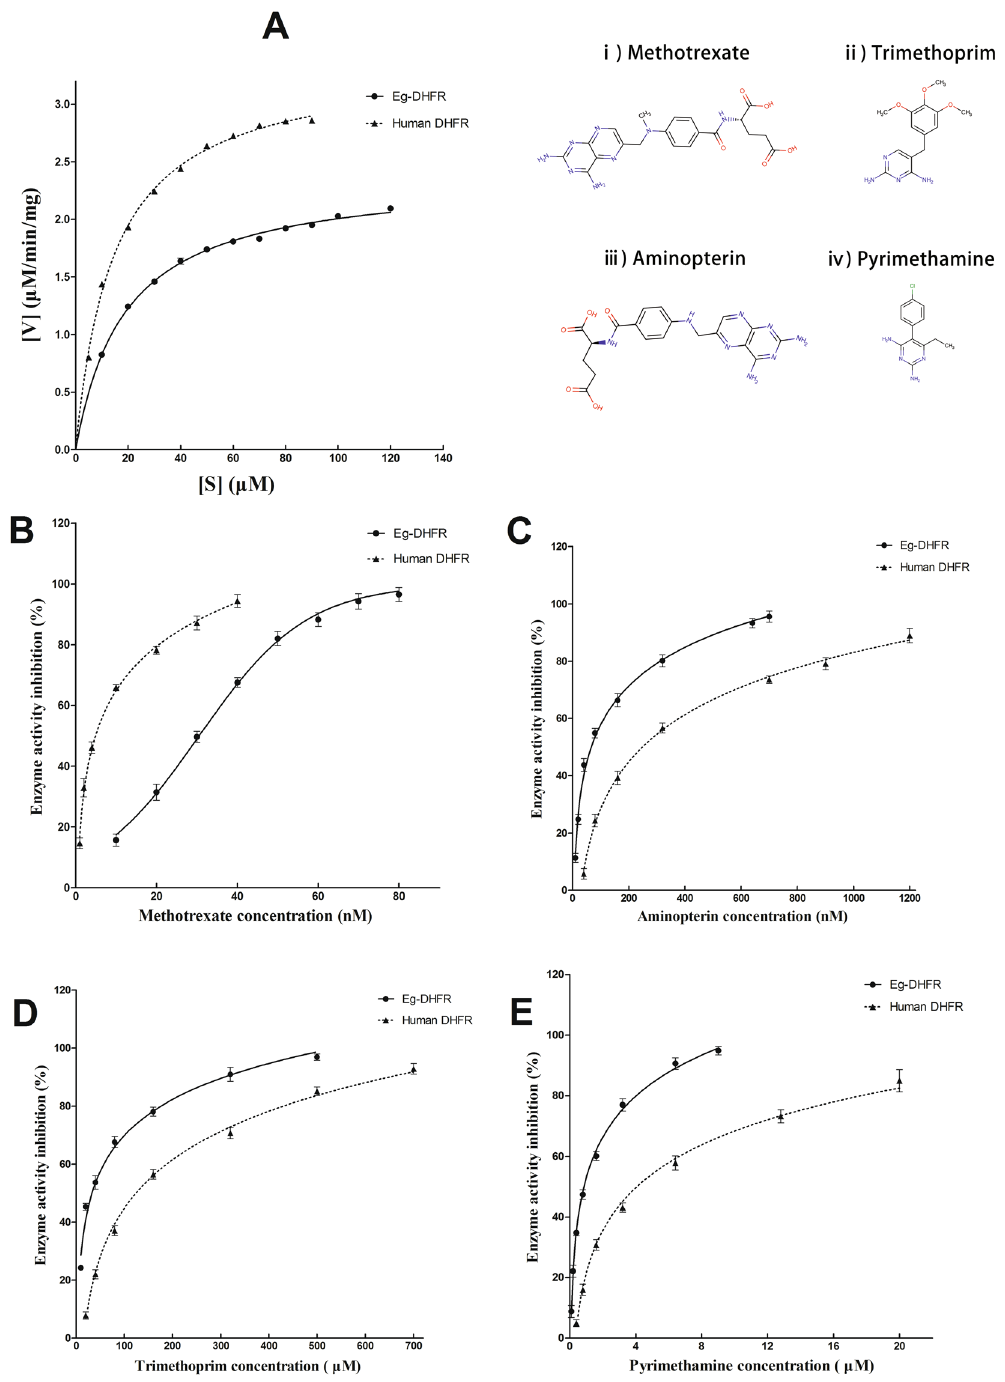
Figure 5. Enzymatic activity of rEg-DHFR and inhibitory effect of antifolates. ( A ) The kinetic parameters were calculated by using a Michaelis-Menten curve fit using GraphPad Prism ® software (nonlinear regression). ( B ) Inhibition curves of rEgDHFR and human DHFR enzyme activity by methotrexate. ( C ) Inhibition curves of rEgDHFR and human DHFR enzyme activity by aminopterin. ( D ) Inhibition curves of rEgDHFR and human DHFR enzyme activity by trimethoprim. ( E ) Inhibition curves of rEgDHFR and human DHFR enzyme activity by pyrimethamine. The IC 50 of antifolates were calculated and represented using means standard errors of the means. Chemical structures of the antifolate drugs methotrexate (i), trimethoprim (ii), aminopterin (iii), and pyrimethamine